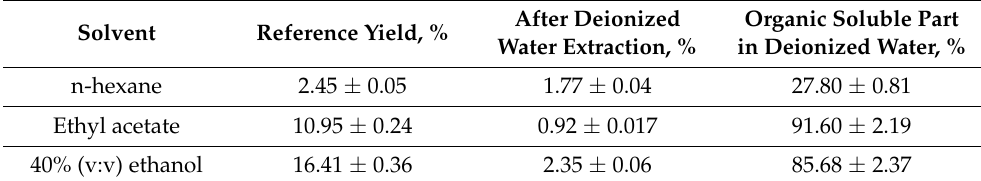
Table 2. Reference extraction yield with organic solvents in comparison with the sequential extraction with organic solvents after the single-step extraction with deionized water at predefined extraction parameters and organic soluble part in deionized water, %.